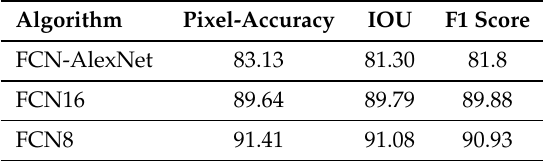
Table 5. Segmentation framework comparison analysis.